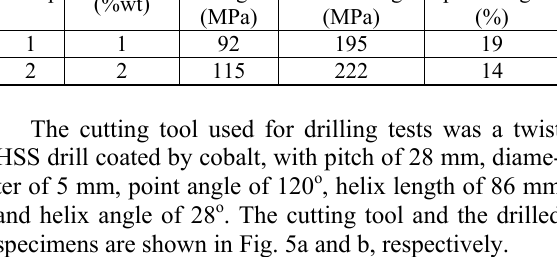
Table 3. Obtained results of universal tensile test. SiC content Group (%wt)